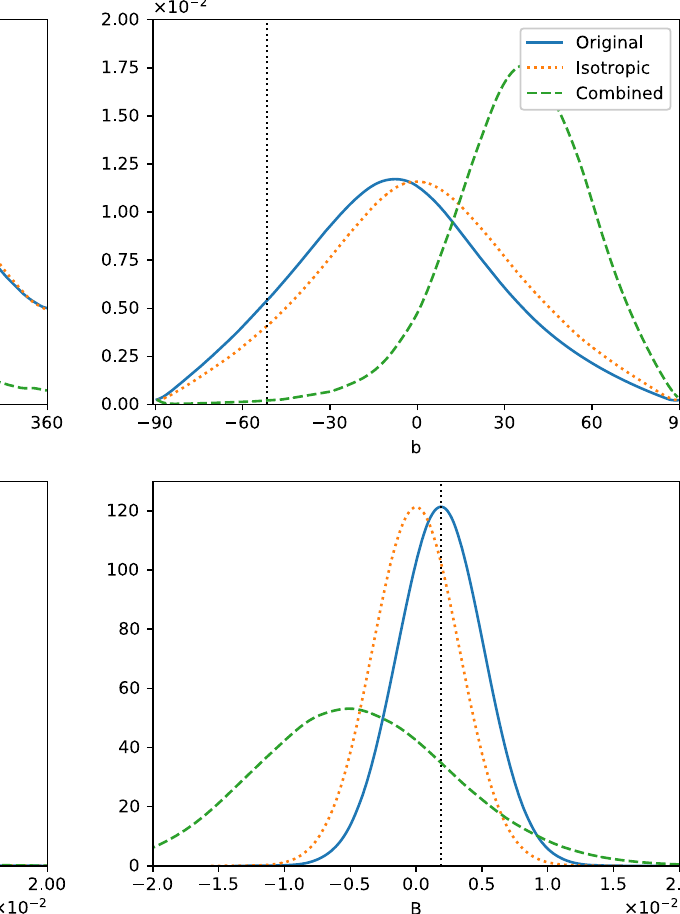
samples. Green dashed lines represent results of combined fitting of dipole parameters and nuisance parameters